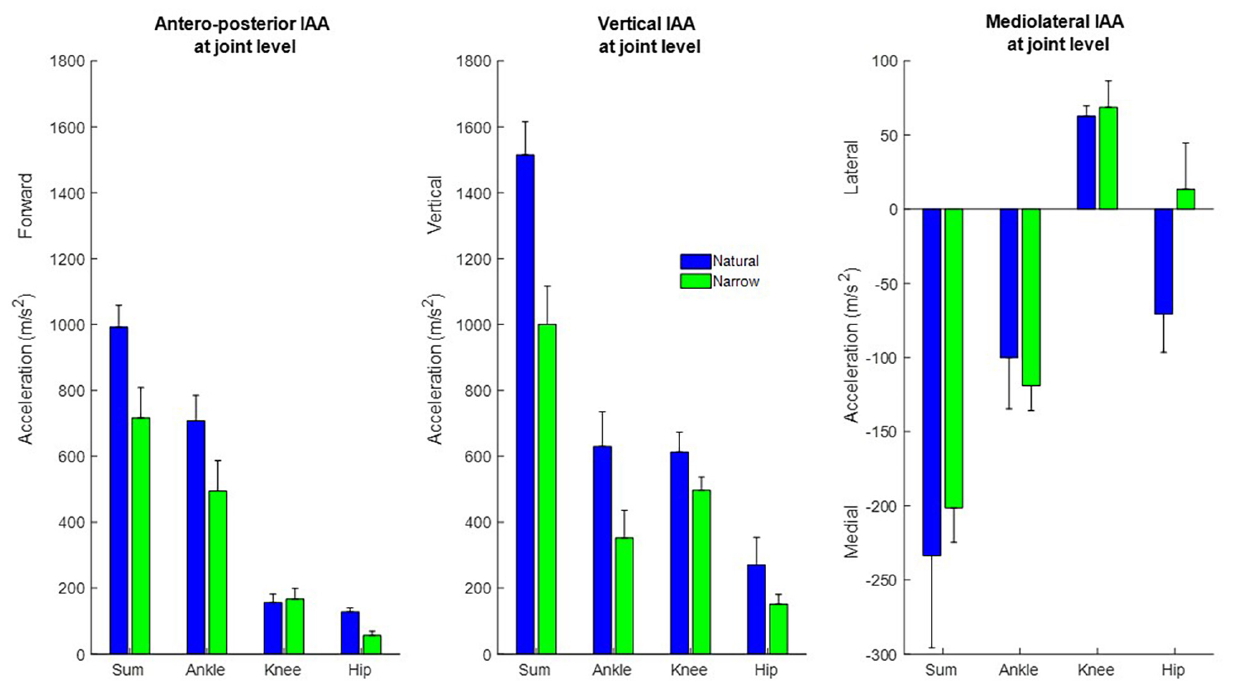
FIGURE 4 | Cumulative contribution of all muscles, and of muscles spanning the ankle, knee, and hip, to the forward, vertical, and medio-lateral COM accelerations, in the natural (blue) and narrow (green) trials (mean ± SD). The cumulative induced accelerations at the joint level were computed as the sum of the cumulative accelerations during the stance phase induced by all muscles spanning that